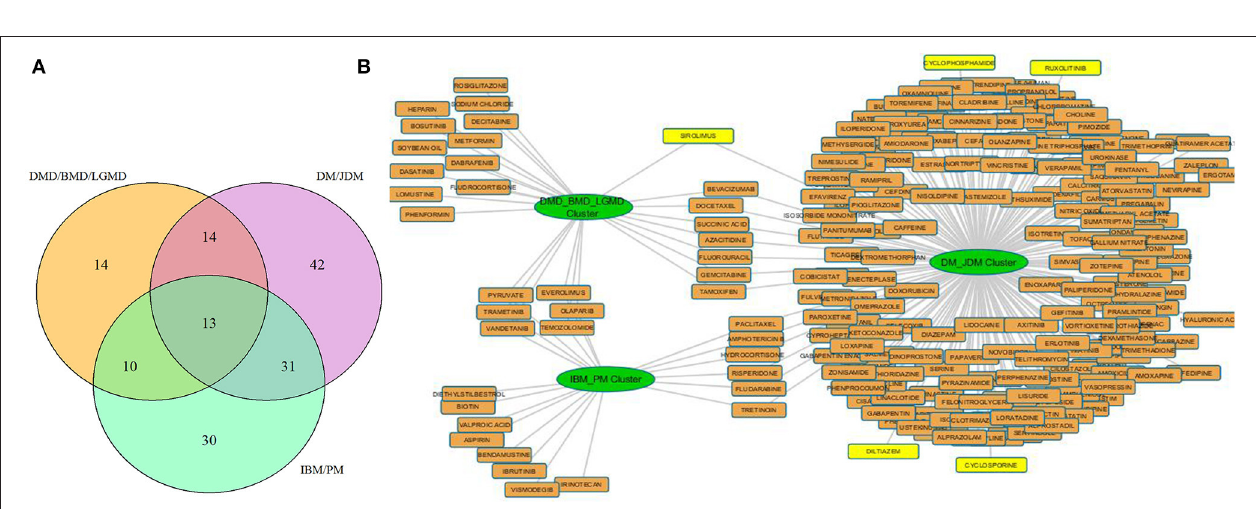
FIGURE 5 | Drug disease network for 3 disease clusters. (A) shows the number of protein modules associated with each disease cluster considered e.g., 13 protein modules were shared among all clusters, 14 modules were uniquely regulated in the DMD/BMD/LGMD cluster, 30 in the IBM/PM cluster and 42 in the DM/JDM cluster. (B) represents the approved drugs (Table S8) associated with the protein modules uniquely regulated in each disease cluster. Nodes in yellow are drugs currently utilized for treatment in the diseases associated with the cluster. Sirolimus and Ruxolitinib, investigational therapeutics currently used in DM/JDM were also identified within the DM_JDM